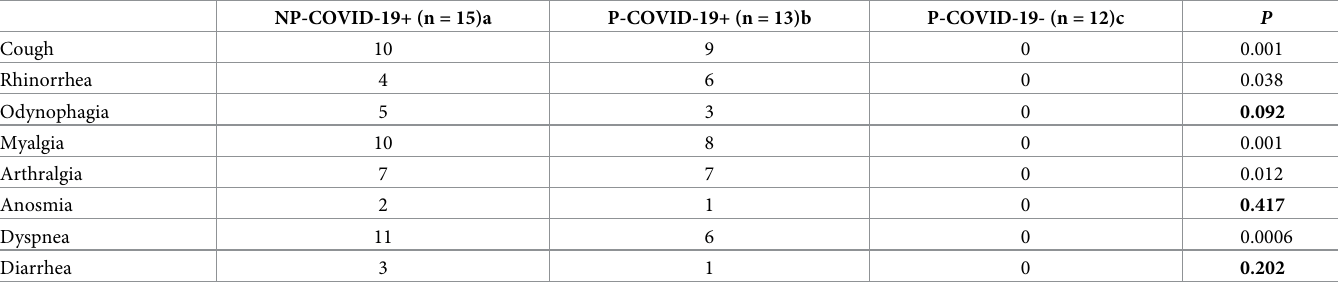
Table 2. Frequency of COVID-19 signs and